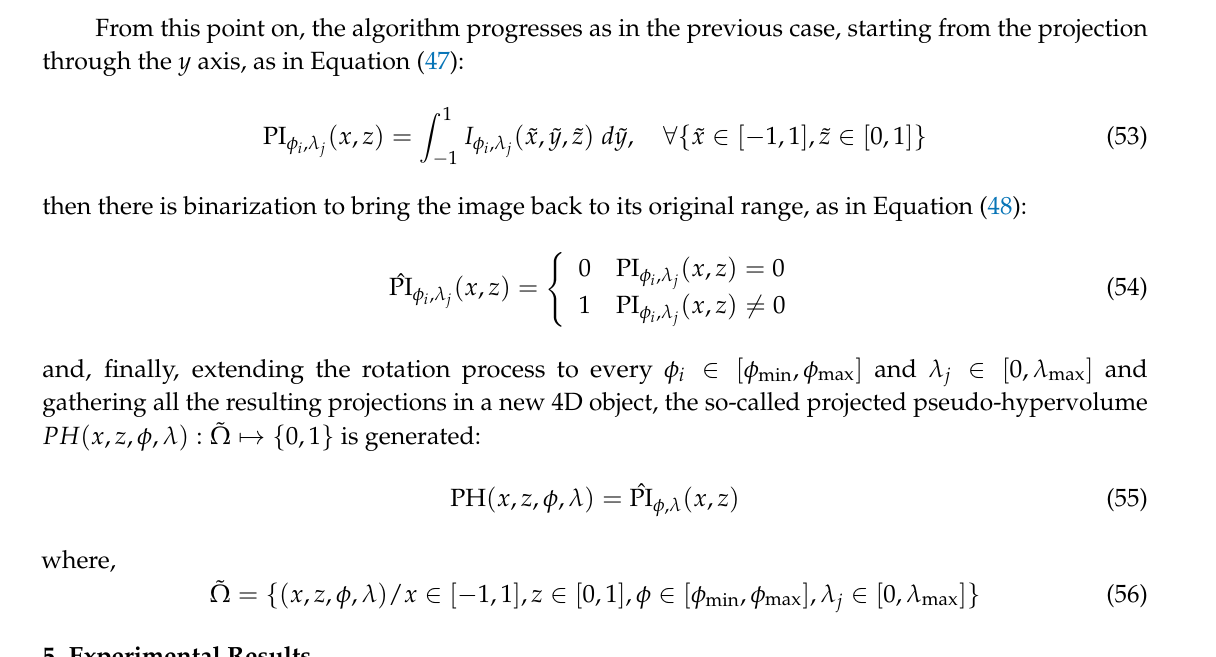
( x , z ) ; ( d ) Complete PV ( x , z , θ ) object, after gathering all i